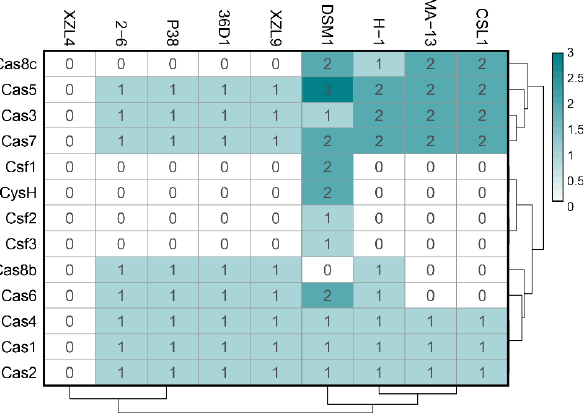
Figure 9. Heat map distribution of cas operon genes among W. coagulans strains. Green and white represent the highest and lowest number of genes.